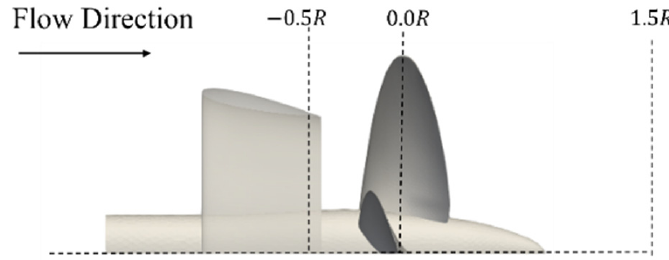
Figure 7. Flow measurement locations. Figure 6. Instantaneous non-dimensional axial velocity contours on longitudinal plane for large duct ( 𝐷 (cid:3005) = 𝐷 (cid:3017) ).